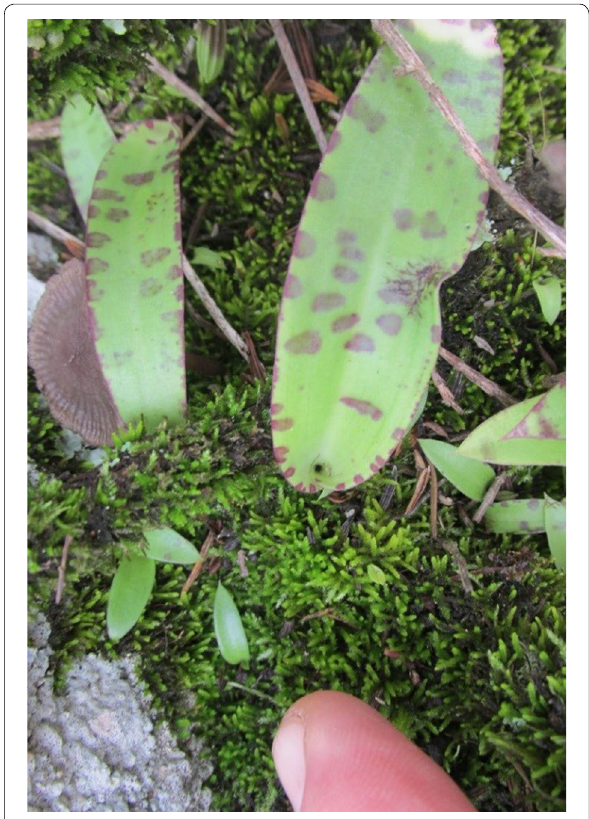
Fig. 4 (Left) A strap leaf of the terrestrial orchid, Cynorkis gibbosa , showing characteristic mottled pigmentation, rooted in moss on a granite outcrop/seepage slope on the Itremo Massif. Small seedlings are shown at the lower left, presumably from the same species. Seed- ling stages are often detected in close proximity to mature plants sharing the same